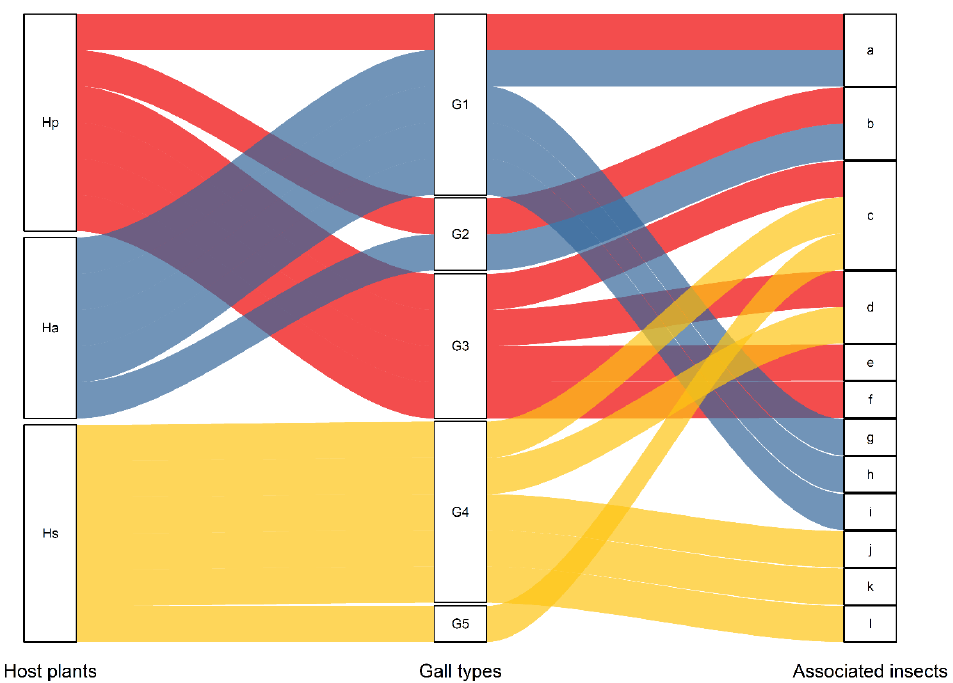
Figure 1. The relationships between the types of flower-like galls and their associated insects on three species of Haloxylon Worldwide. Hp: H. persicun, Ha: H. ammodendron ,Hs: H. salicornicum ; G1: leafy-bracted galls, G2 – G4: flower-like galls, G5: spike-like galls; a-l indicate 12 species of associated insects. a: C. notata , b: Aceria haloxylonis , c: Pteromalidae, d: Thrips, e: Psyllidae, f: Pseudococcidae, g: C. robusta , h: C. azurea , i: C. nana , j: Pyralidae, k: Acari (Mites), l: